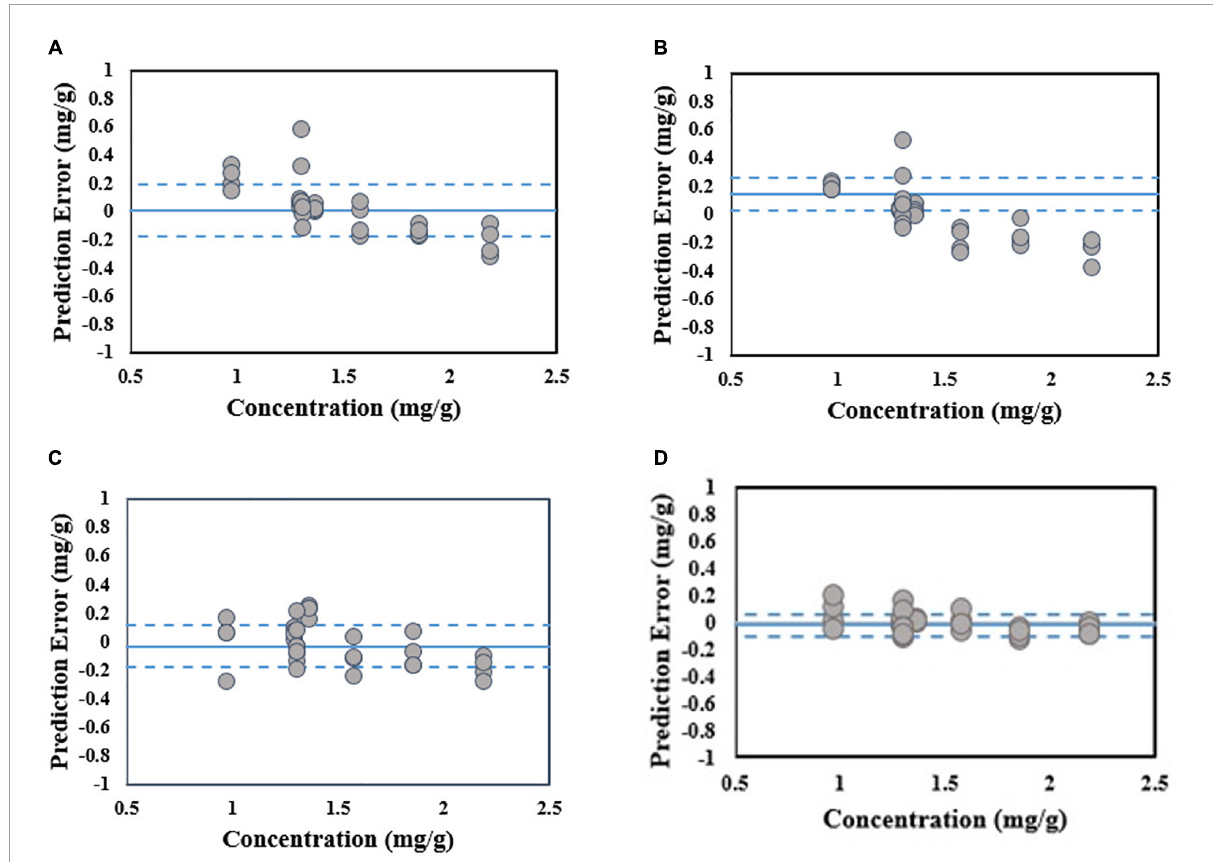
FIGURE5 Scatter plot of phenolic concentration reference value versus prediction errors for validation dataset. The average value and the lines of average ± one standard deviation of prediction error are shown in solid and dashed blue lines respectively. (A) SVM, (B) RegTree, (C) PCR, and (D) PLSR.